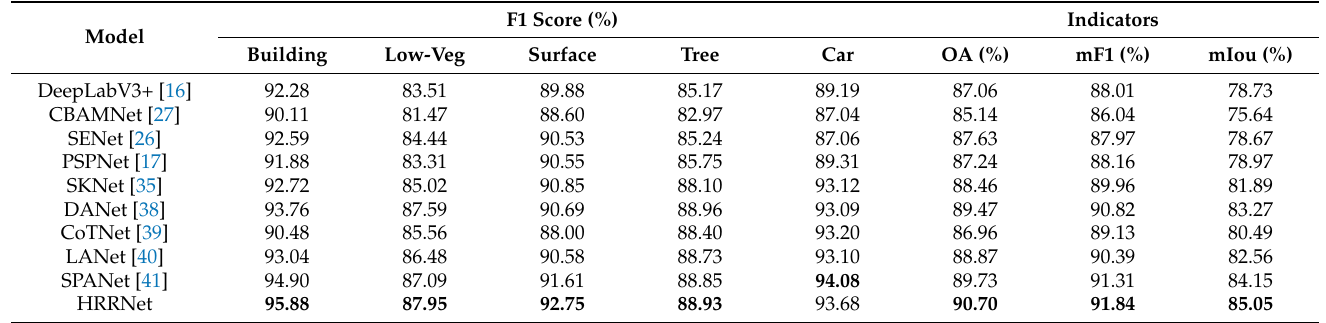
Table 6. Experimental results for various models (on Potsdam data), the optimal results are bolded.